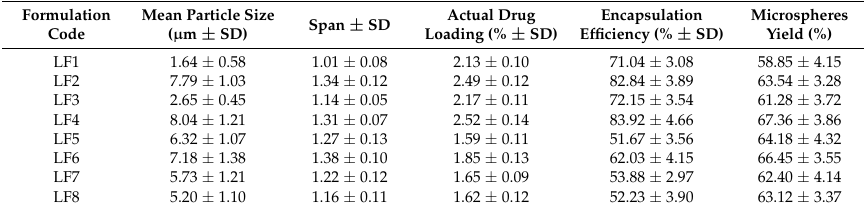
Table 2. Characteristics of lysozyme loaded microspheres prepared in different